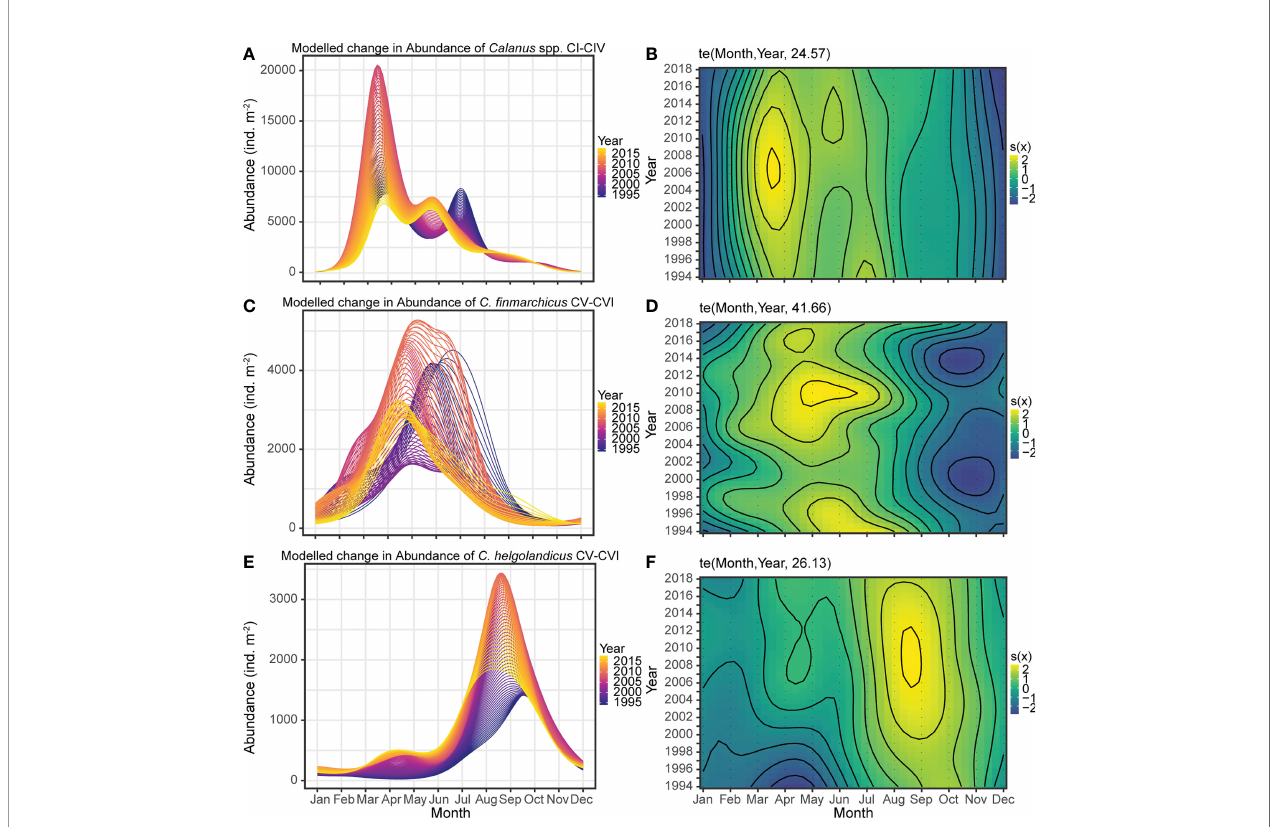
FIGURE 6 | Modelled abundance of Calanus spp. stages CI-IV (A) , C. fi nmarchicus CV-VI (C) , and C . helgolandicus CV-VI (E) showing the within year variation throughout the study period. Model predictions are based on a tensor product smoother for the Month x Year interaction. Each line represents a year shown in a color gradient for better visualization. The smoother is also shown in the two-dimensional plane, with contours and color gradient denoting the intensity of the smoother effect, (B, D, F) for the three time series